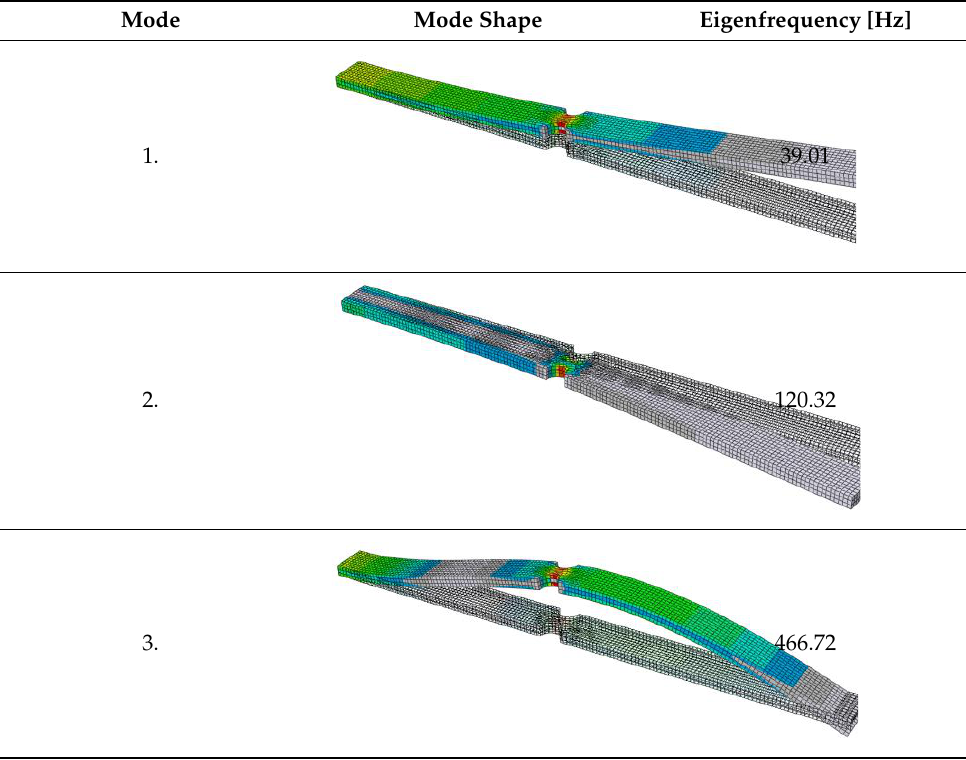
Table 2. Modal analysis results.